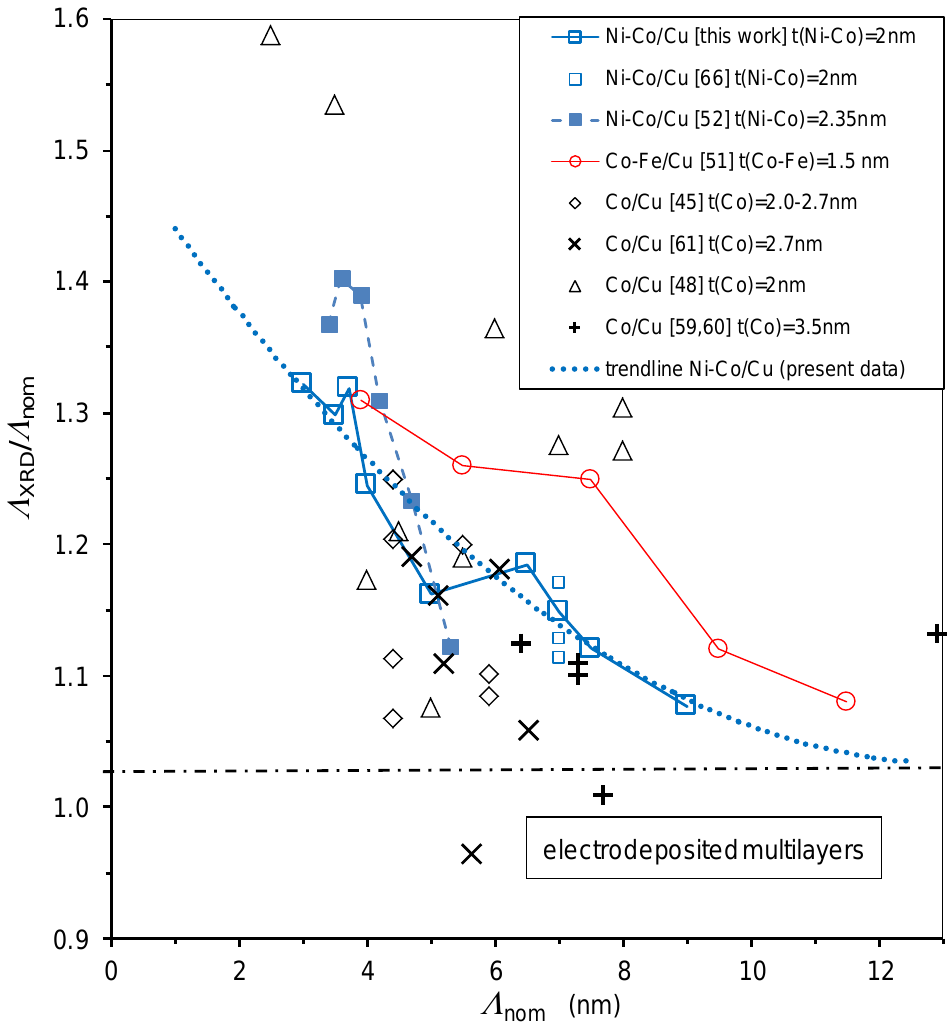
Figure 4. Ratio of the nominal and measured bilayer periods, Λ XRD / Λ nom vs. nominal bilayer thickness Λ nom for the present Ni-Co/Cu multilayers (thick squares) and for other electrodeposited multilayers as indicated in the legend. The dotted line is just for indicating the overall trend.